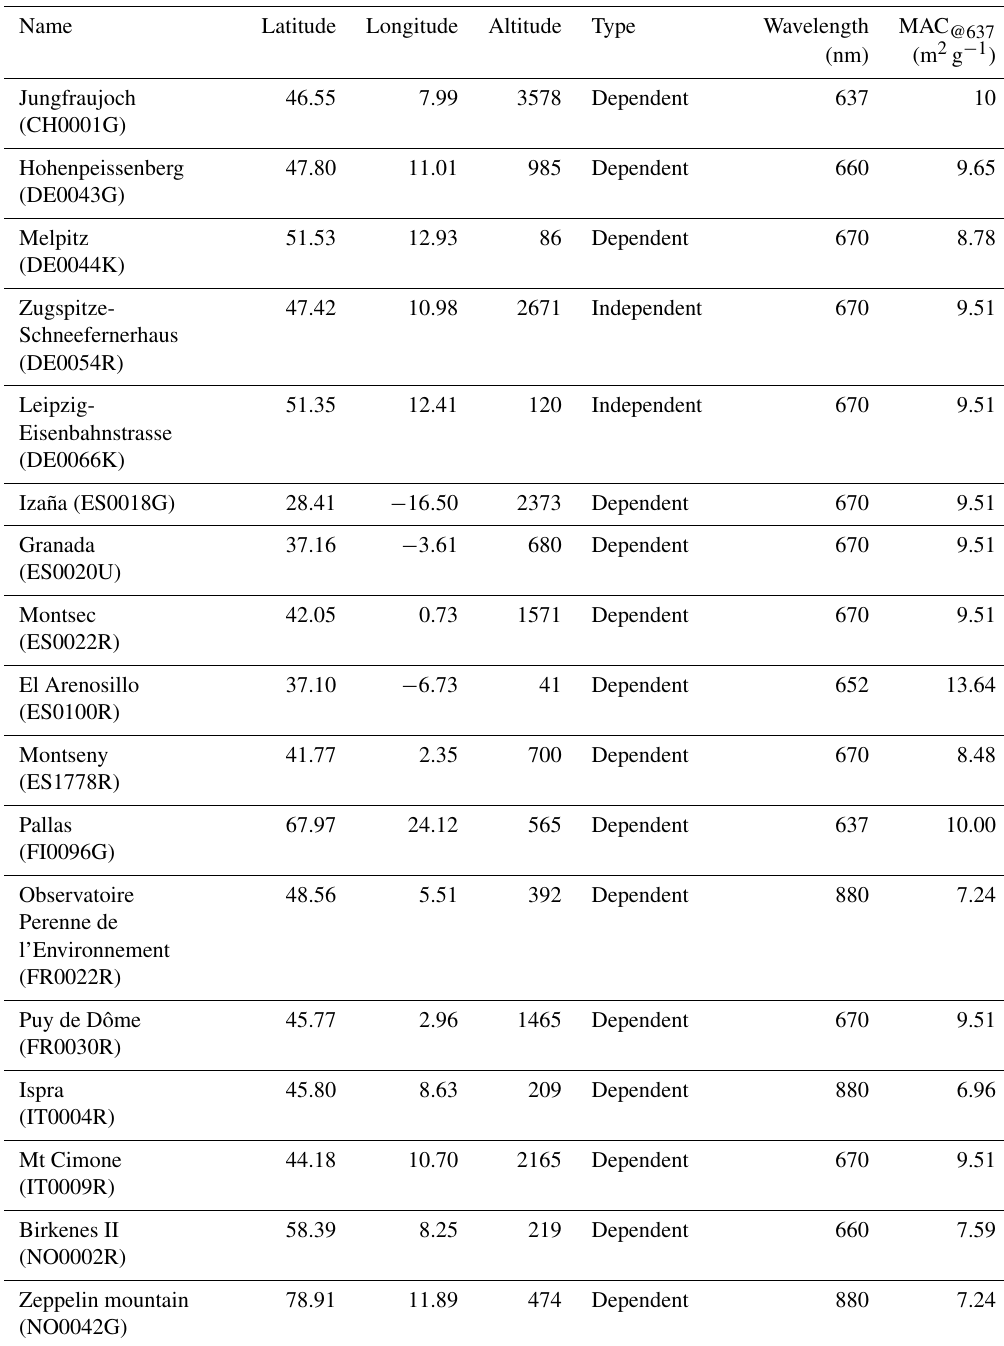
Table 1. Observation sites from the ACTRIS platform used to perform the inversions (dependent observations) and to validate the posterior emissions (independent observations) (the altitude indicates the sampling height in metres above sea level). A Multi-Angle Absorption Photometer (MAAP) was used at all sites, except El Arenosillo (ES0100R), where a Continuous Light Absorption Photometer (CLAP) was used, Birkenes (NO0002R), where a Particle Soot Absorption Photometer (PSAP) was used and Observatoire Perenne de l’Environnement (FR0022R) and Zeppelin (NO0042G), where an Aethalometer (AW-31) was